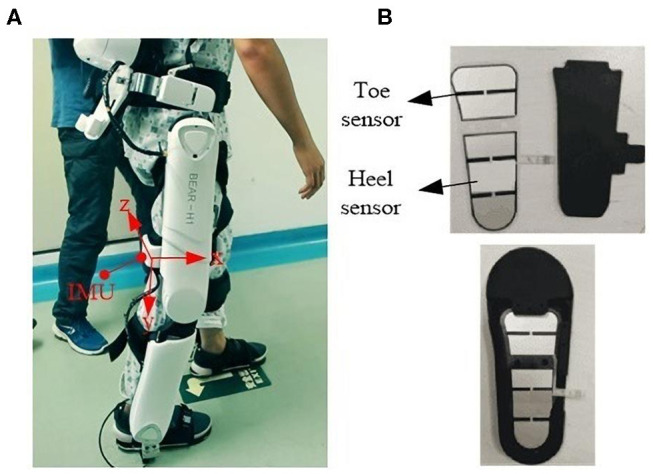
Data acquisition system. (A) A subject wearing the BEAR-H1 robot; (B) two pressure sensors.